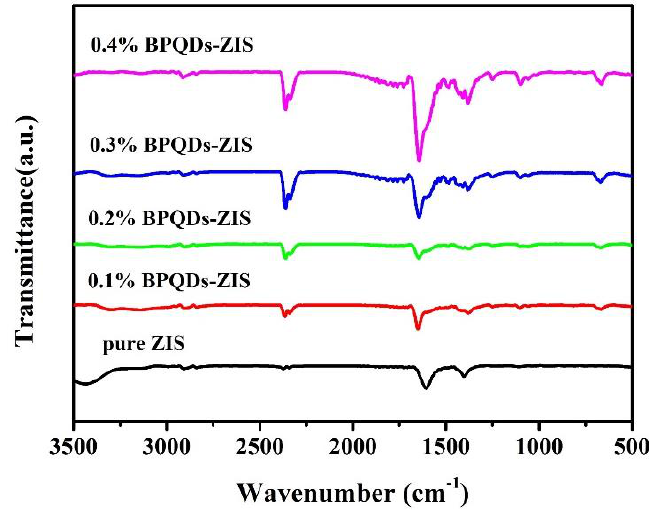
Figure 5. Fourier-transform infrared (FT-IR) spectra of ZnIn 2 S 4 and the BPQD–ZIS samples.